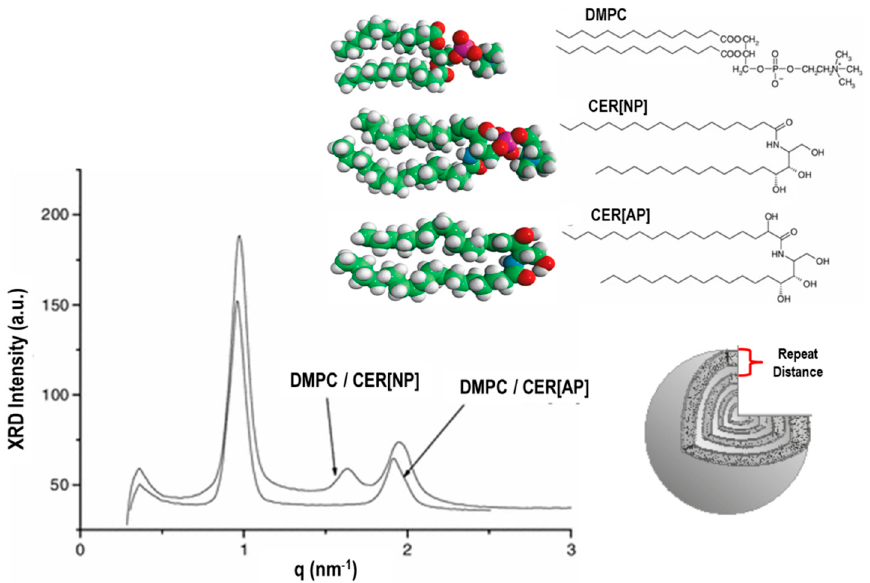
Figure 17. X-ray diffraction patterns for the mixed lipid system composed of DMPC/ α -hydroxy-N-stearoyl phytosphingosine CER[AP] and of DMPC/N-stearoyl phytosphingosine CER[NP] multilamellar vesicles (MLVs) at the temperature of T = 30 °C Adapted by permission from Springer Nature: [156] (Appl. Phys. A) by Kiselev et al., Copyright 2013.